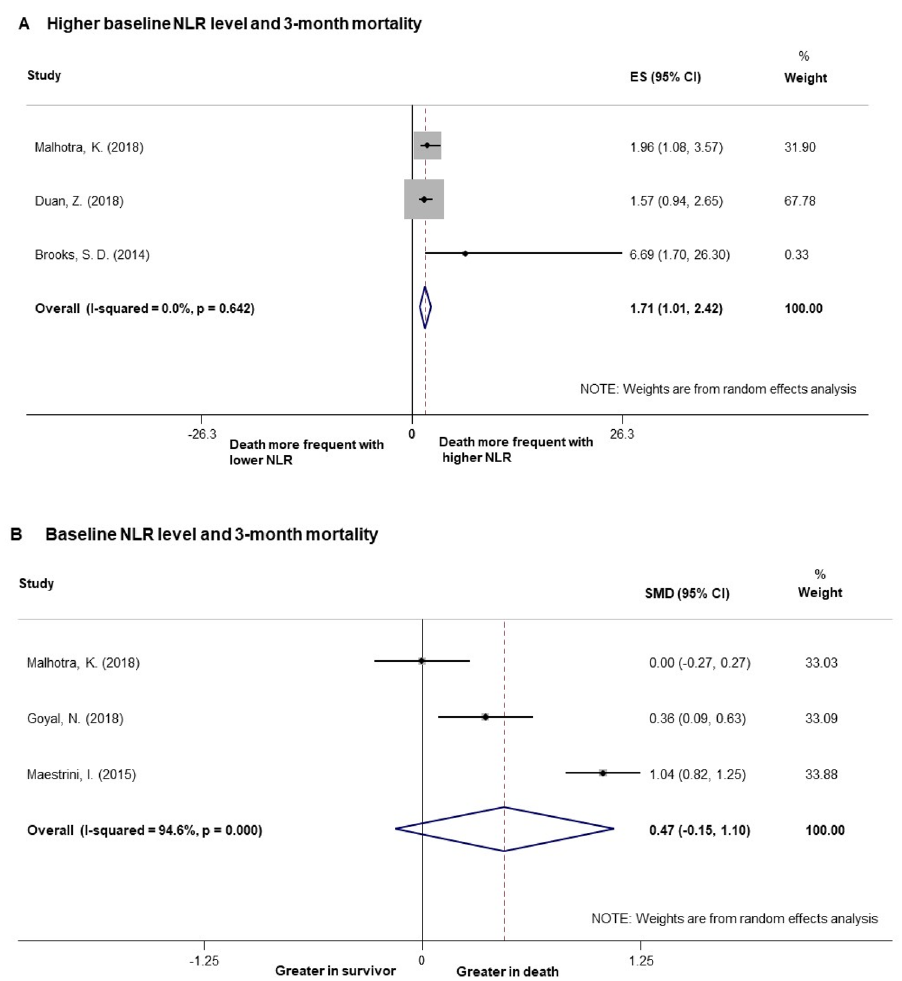
Figure 5. Forest plots of baseline NLR level and 3-month mortality. ( A ) Pooled analysis of 3-month mortality with studies regarding NLR as binary data. ( B ) Pooled analysis of 3-month mortality with studies regarding NLR as continuous data. NLR neutrophil to lymphocyte